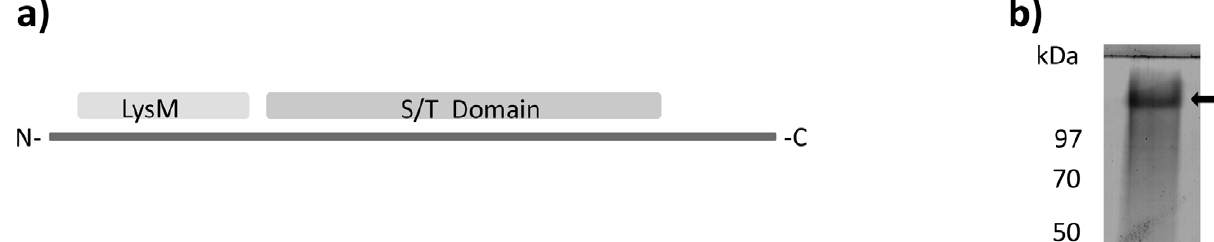
Figure 1. Structure, purification and location of the ST peptide. a ) Domain structure of the protein D1, where the ST peptide is encoded (S/T domain); b ) Western blot performed with a specific horseradish peroxidase-conjugated anti His 5 antibody, showing the anomalous migration of the purified His-tagged ST peptide (marked with an arrow); c ) Western blot using the polyclonal anti-STp serum as primary antibody; specific immunoreactive bands are labelled with arrows; -: complete medium (negative control), HC # : protein extracts obtained from culture supernatants of healthy colonic biopsies, F # : Some culture supernatants were 0.2 m m filtered prior to protein extraction, D # and E # : protein extracts from culture supernatants of human epidermal and dermal layer cultures respectively. doi:10.1371/journal.pone.0036262.g001 abundance of uncharged polar amino acids. This region had a predicted molecular mass of 6.8 kDa, and contained 22.7% of serine and 31.8% of threonine. Polar uncharged amino acids represented around 83% of the total amino acids (Figure 1a).